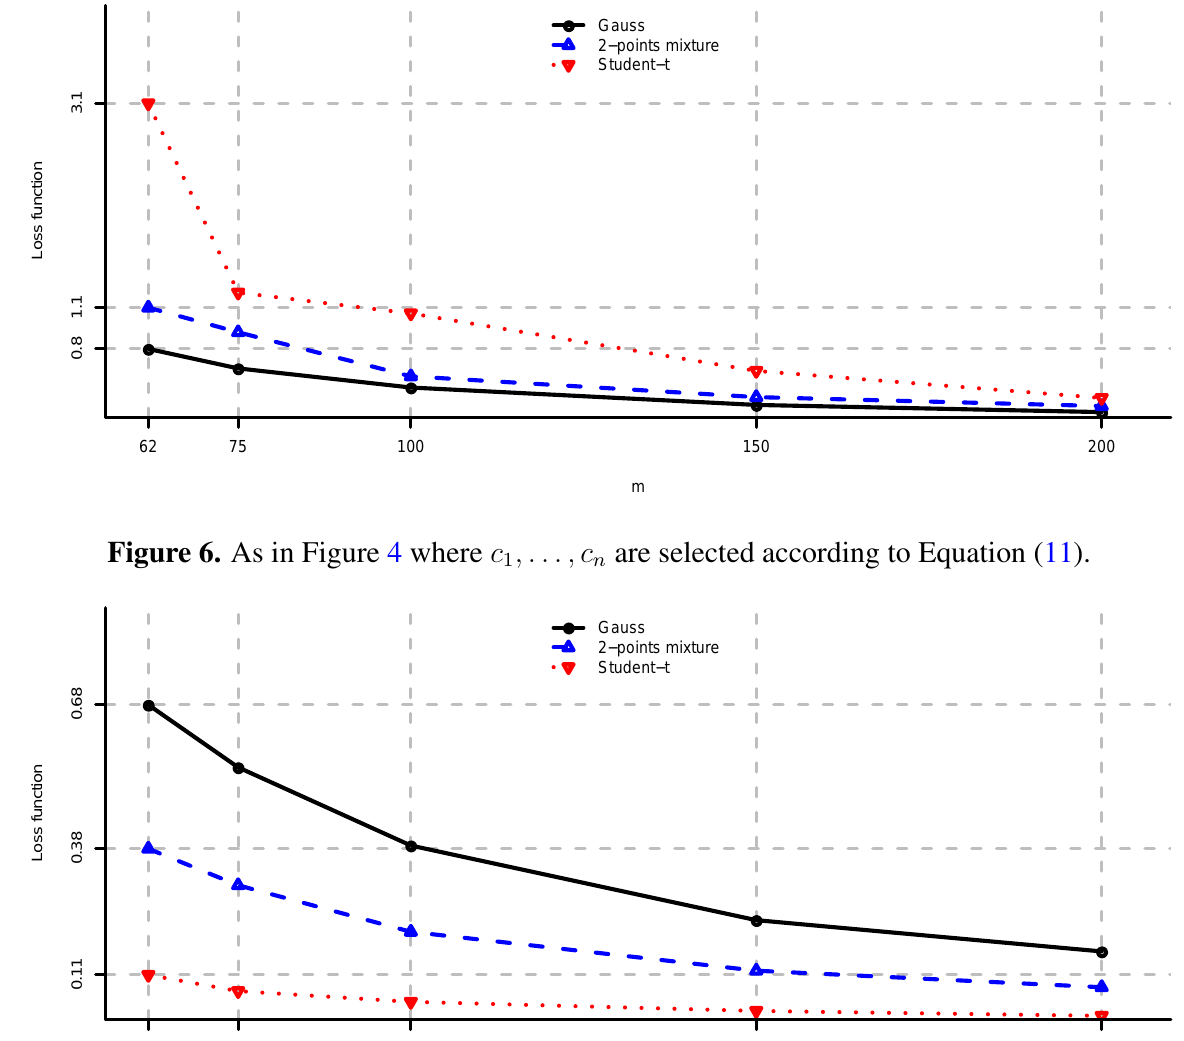
, . . . , c are selected according to Equation (9). 1 n